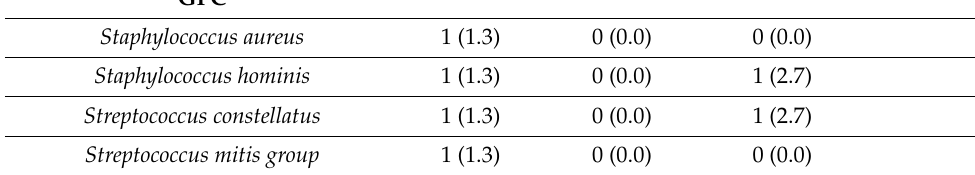
Table 4. Detection rate and strains from blood cultures and first antibacterial and antifungal agents used.